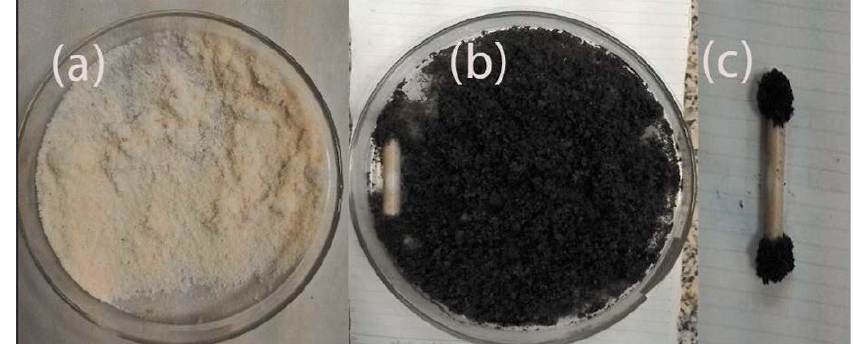
Fig. 1. Photograph of (a) powdered Fish scale and (b) Fish scale after impregnation of Fe3O4 nanoparticles (c) Magnetic fish scale attached to a magnetic rod.